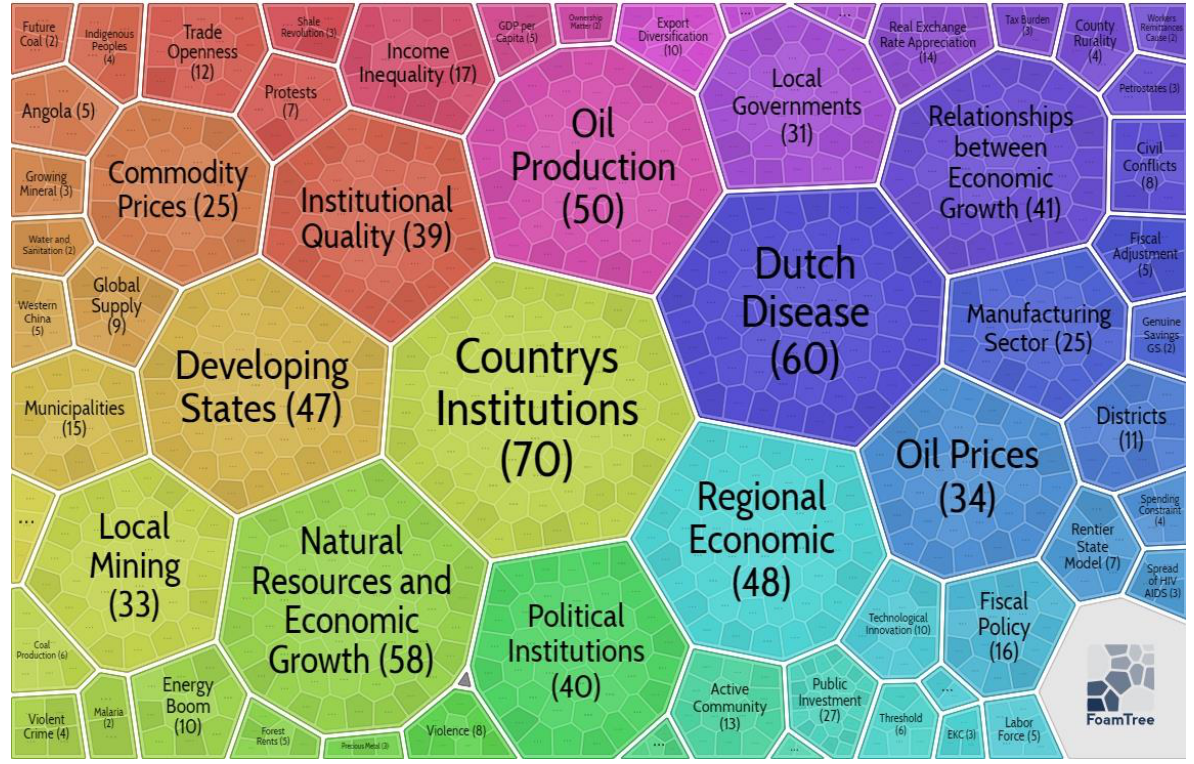
Figure 20. Keywords in Cluster 0 (using Carrot2 4.3.1).